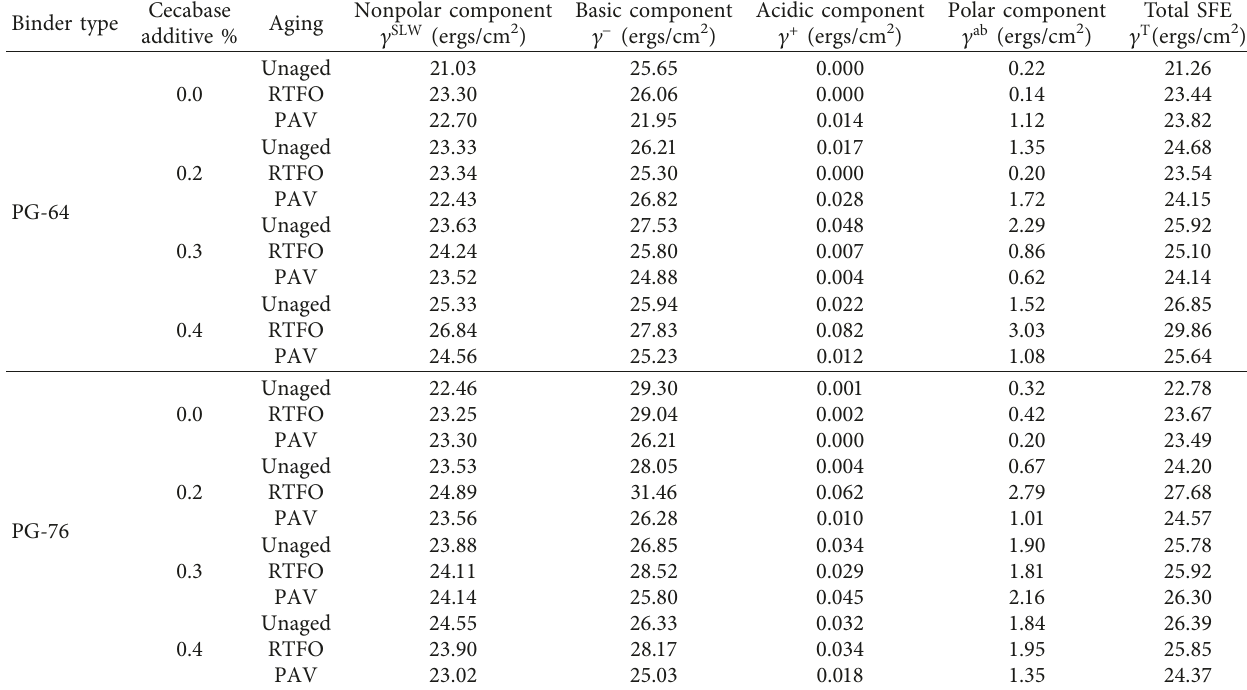
Table 8: SFE components of asphalt binders (receding contact